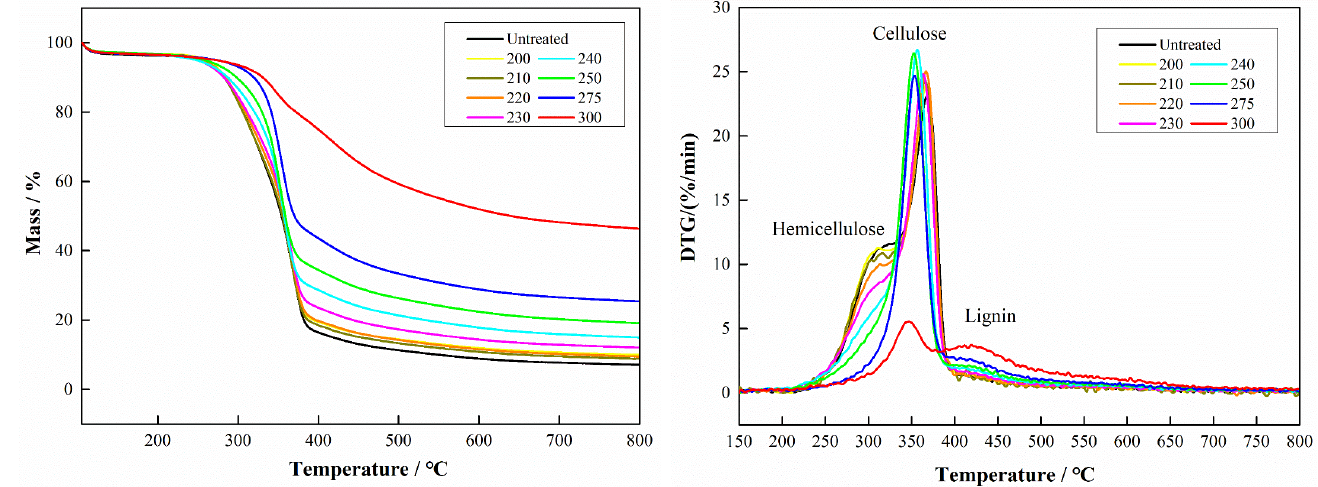
Figure 9. TG curves ( left ) and DTG ( right ) of beech in the heat treatment temperature 200–300 °C range.